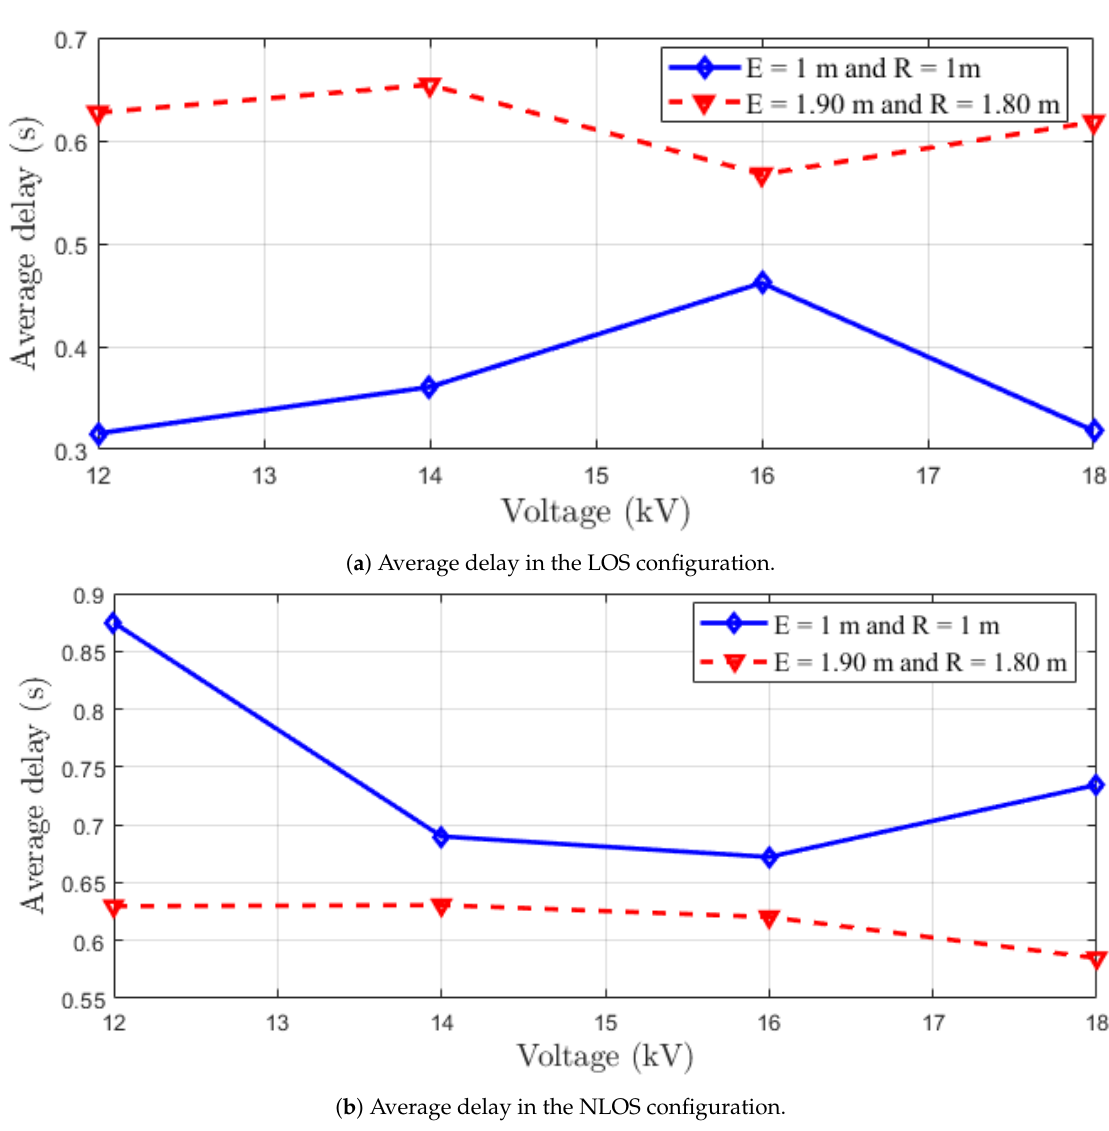
Figure 7. Average delay performance versus the voltage for all